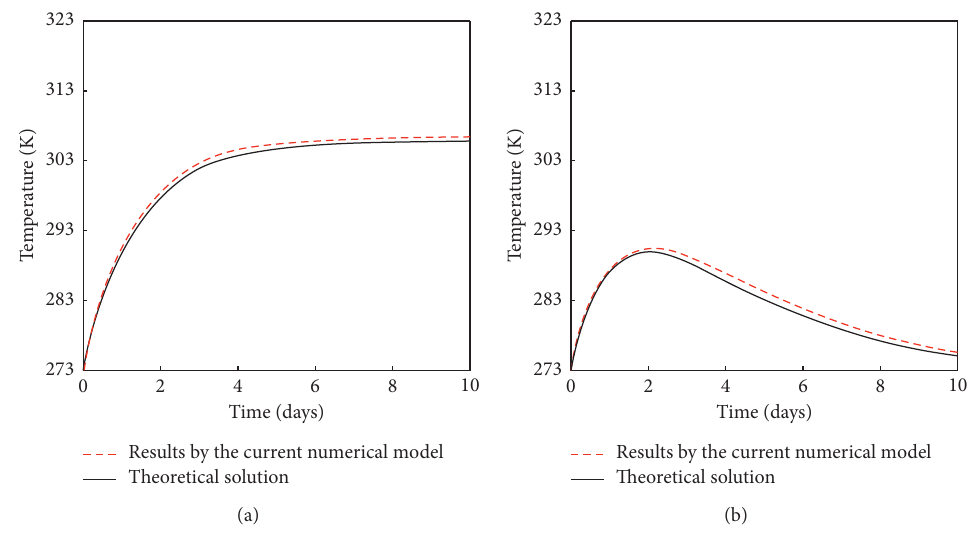
Figure 3: Temperature histories of plane A. (a) Without cooling pipe; (b) with cooling pipe.